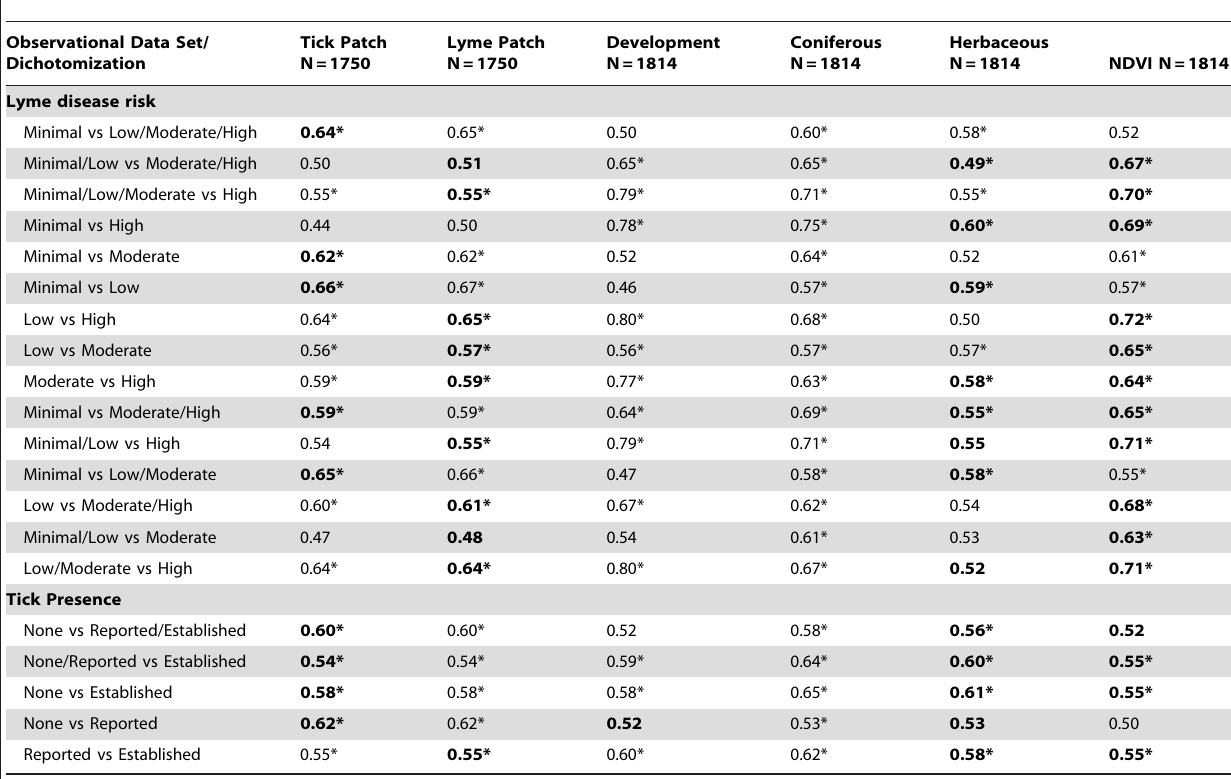
Table 4. AUC values from MLR analyses for predictive models using CDC data as gold standard.